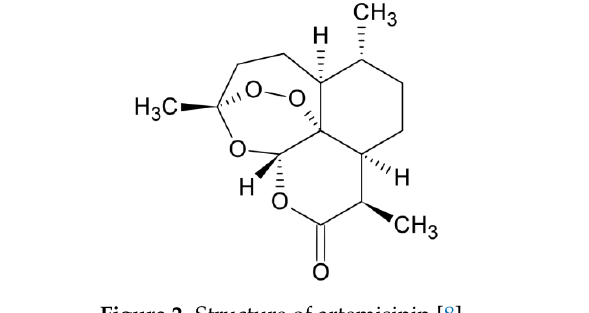
Figure 2. Structure of artemisinin [8].